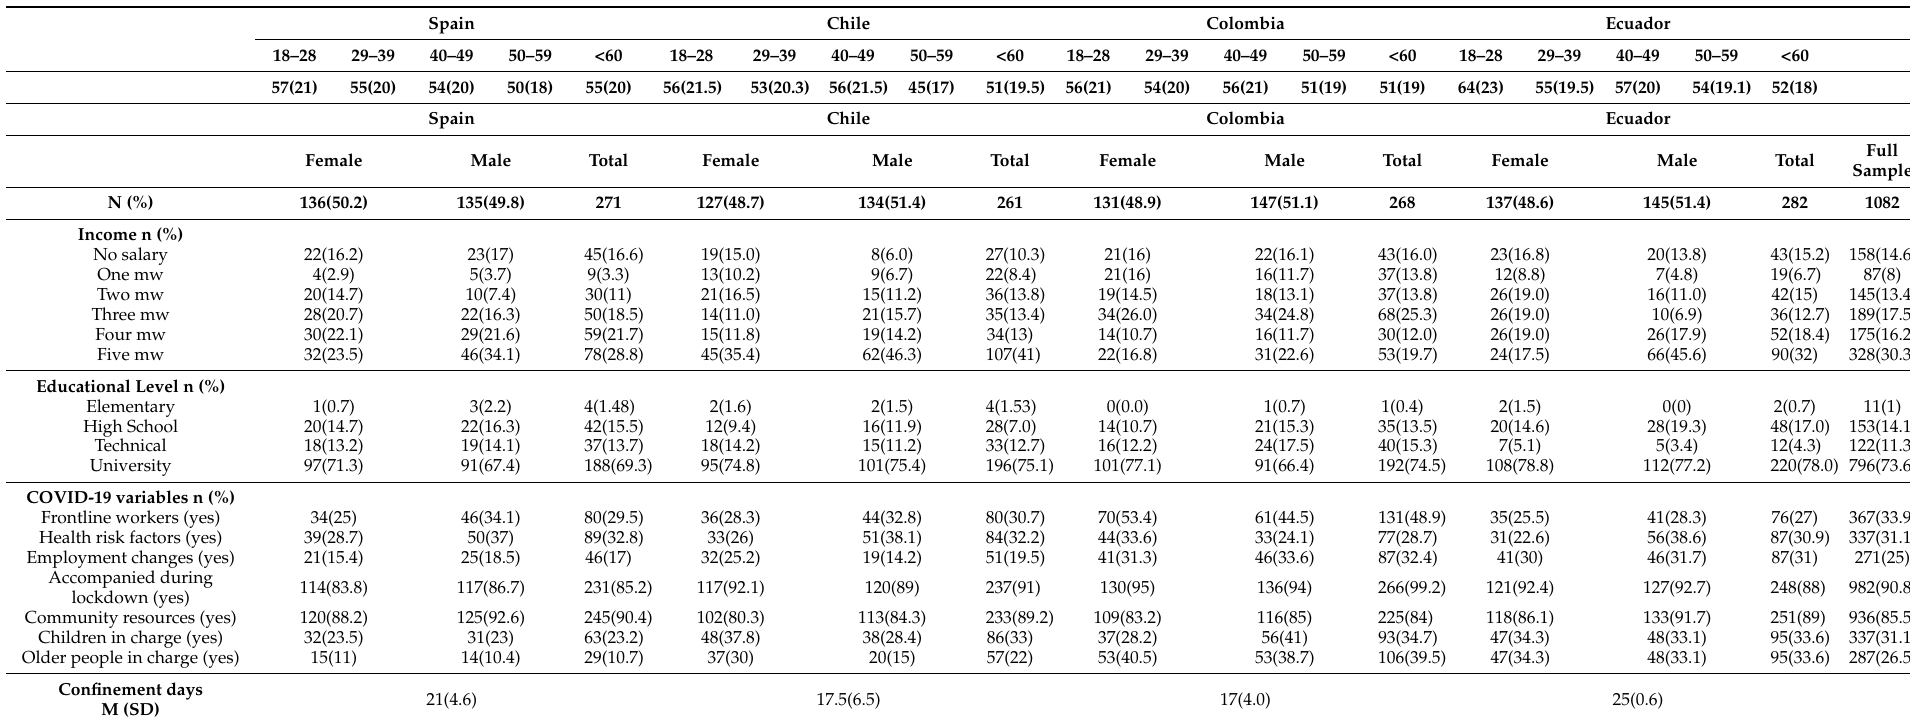
Table 1. Sample age-range distribution and socio-demographics characteristics by country and